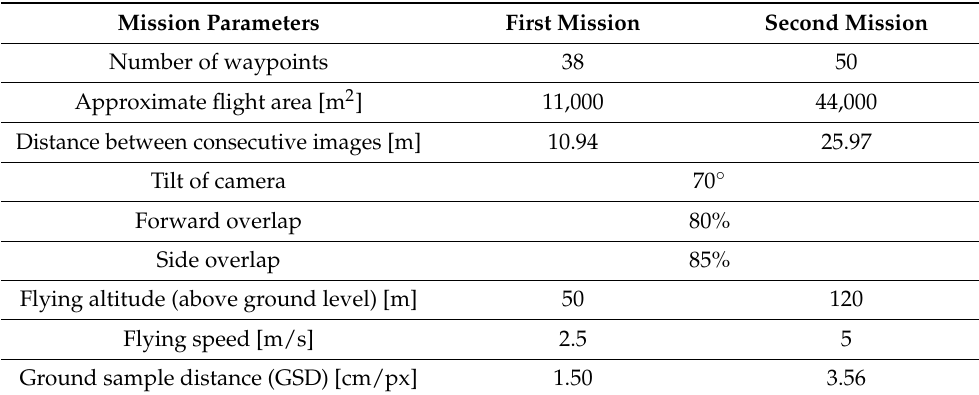
Table 1. The parameters of planned UAS missions.